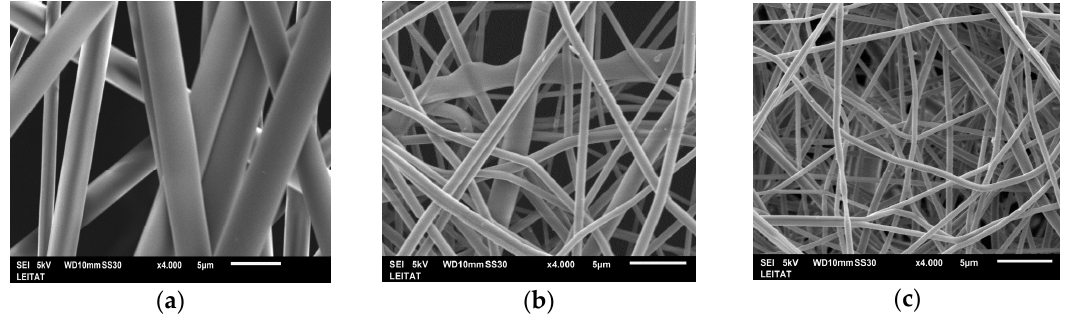
Figure 1. Scanning electron microscope (SEM) images of electrospun poly(ethylene terephthalate) (PET) nanofiber mats synthesized with different solutions: ( a ) PET-1; ( b ) PET-2; ( c ) PET-3.